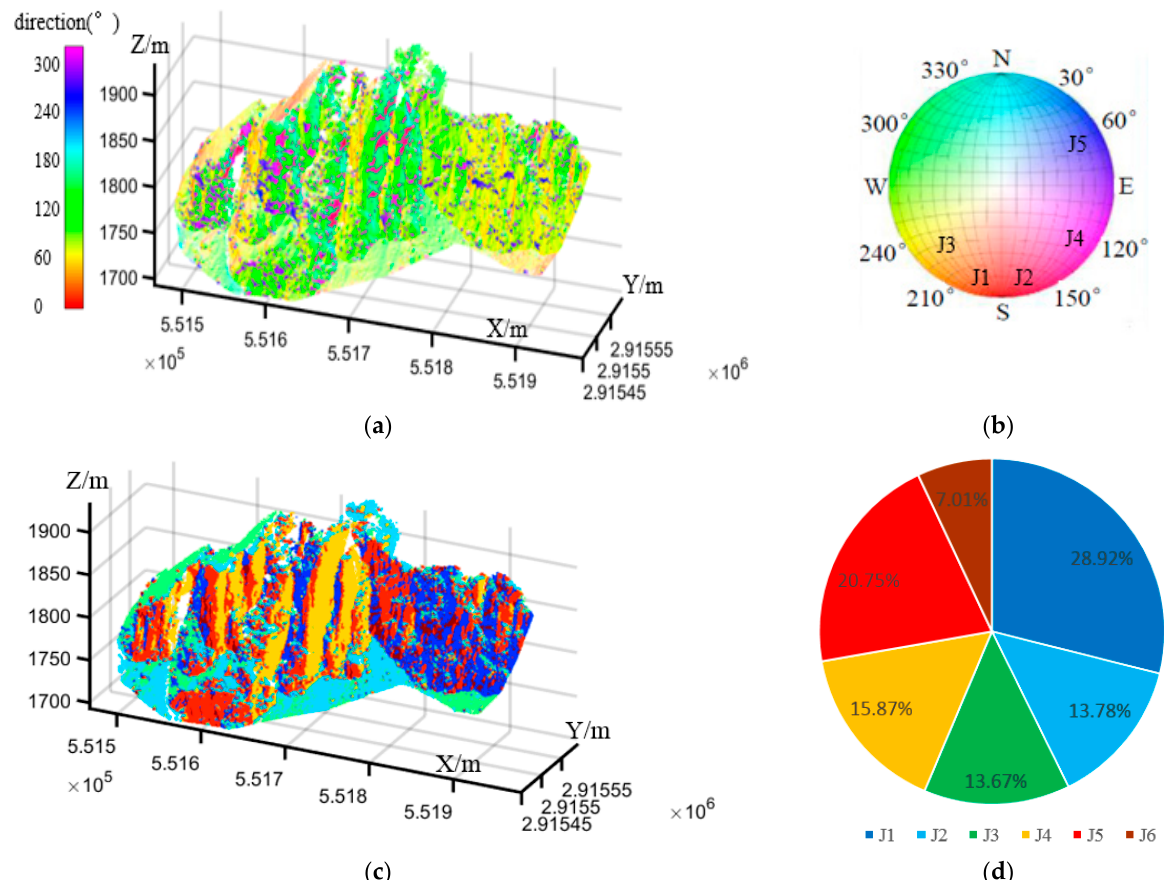
Figure 16. Rock discontinuity production information extraction: ( a ) rock production HSV color rendering; ( b ) rock production distribution; the tendency is mainly concentrated in 120°–240°, a small part is located in 60°, and the slope is relatively steep; ( c ) clustering effect of rock discontinuity surface; ( d ) percentage of area of rock discontinuity (J1–J6).